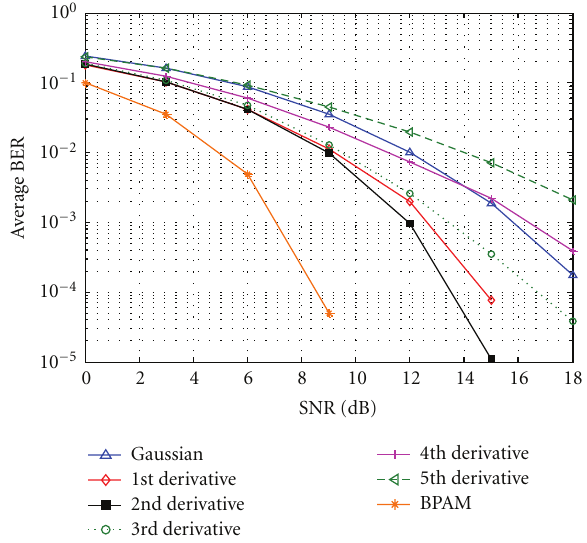
Figure 4: Averaged BER performance using di ff erent templates. or digital circuits. Using an all-digital receiver requires highly sophisticated receiver processors with an analog-to-digital converter (ADC) with sampling rate of 2 or 4 times that of the pulse bandwidth and resolution of 4–6 bits. A hybrid analog and digital receiver can reduce the system complexity and cost by decreasing the sampling rate and resolution of the ADC [49]. The correlator output is then sampled, and the ADC converts the analog-demodulated signal into digital form. The digital baseband circuitry provides control for the clock generation, synchronization, and data